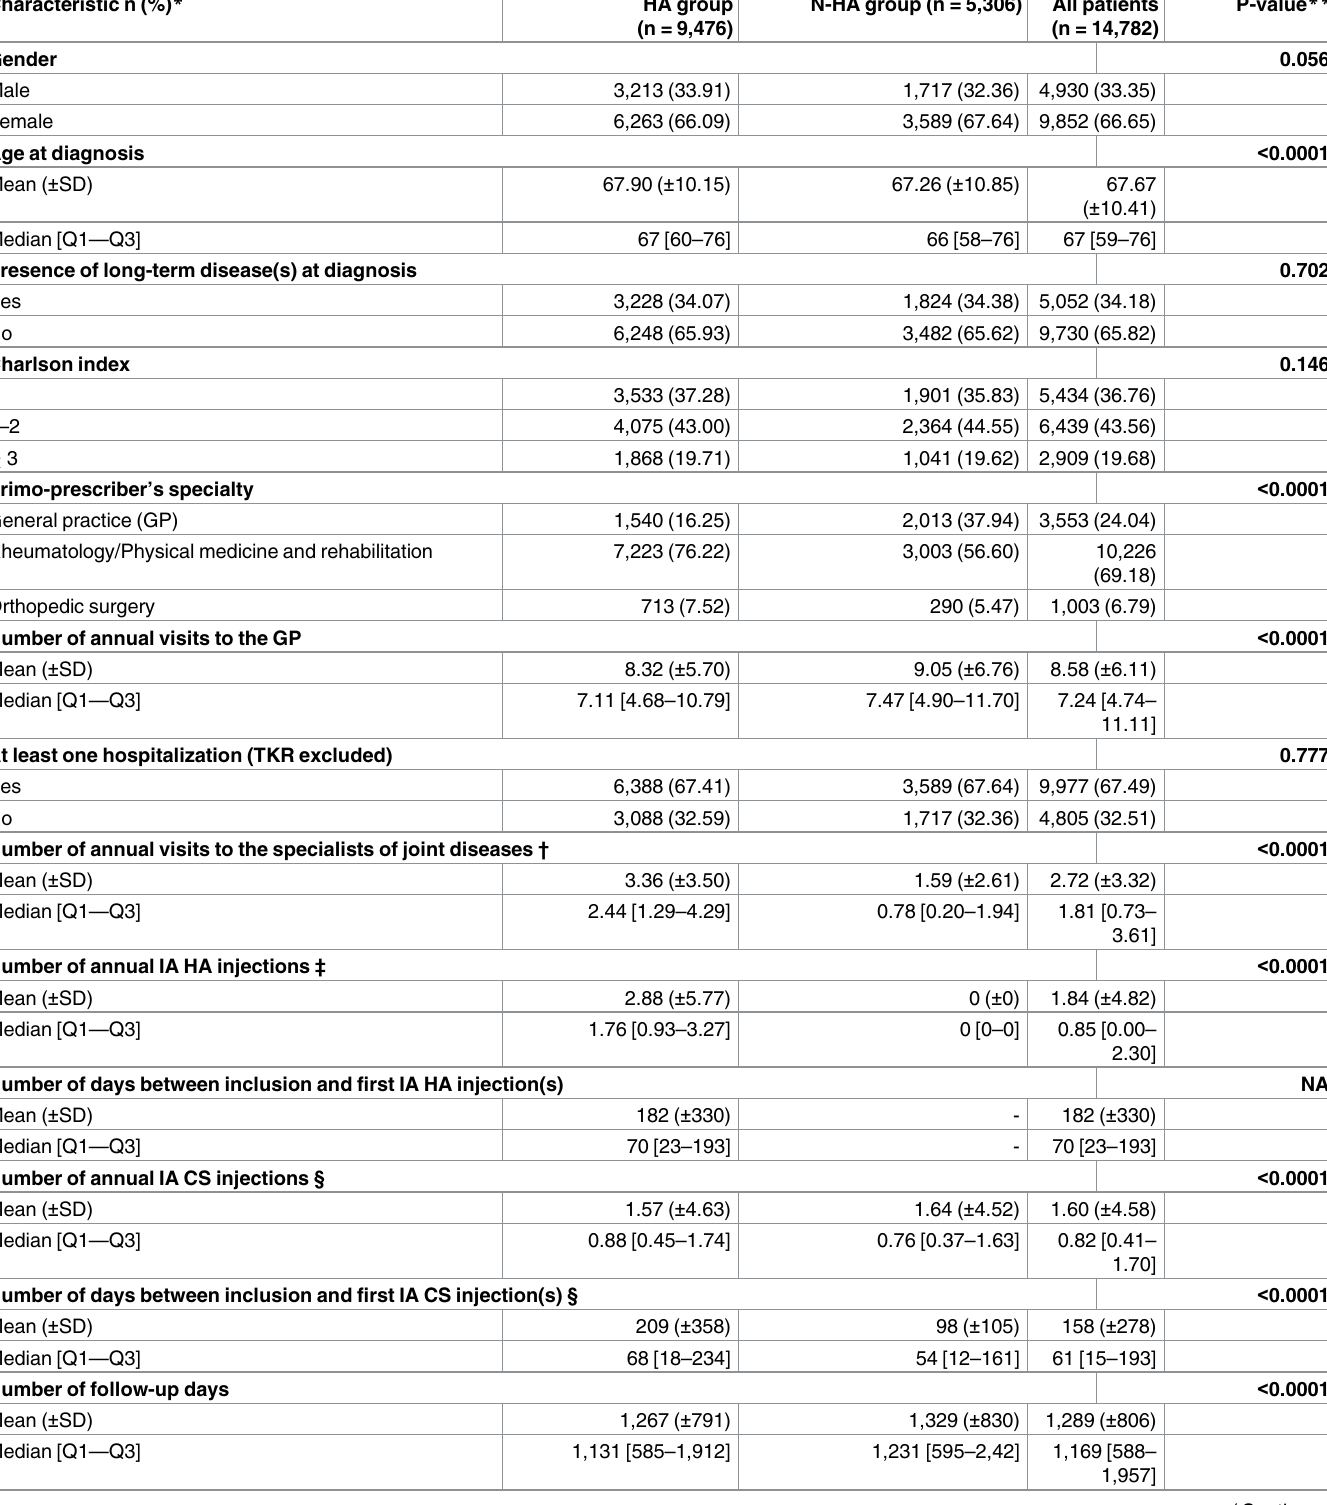
Table 1. Descriptiveanalysis of patients with knee